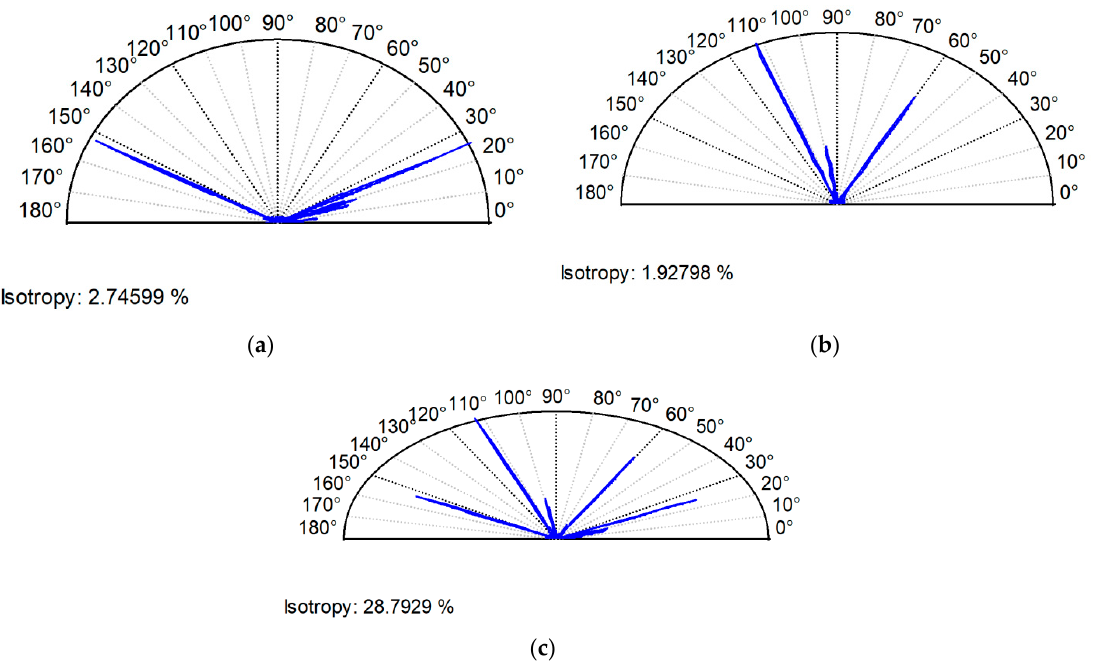
Figure 10. Directionality plots of surface C ( a ), of surface D ( b ), and of equivalent sum surface ( c ).